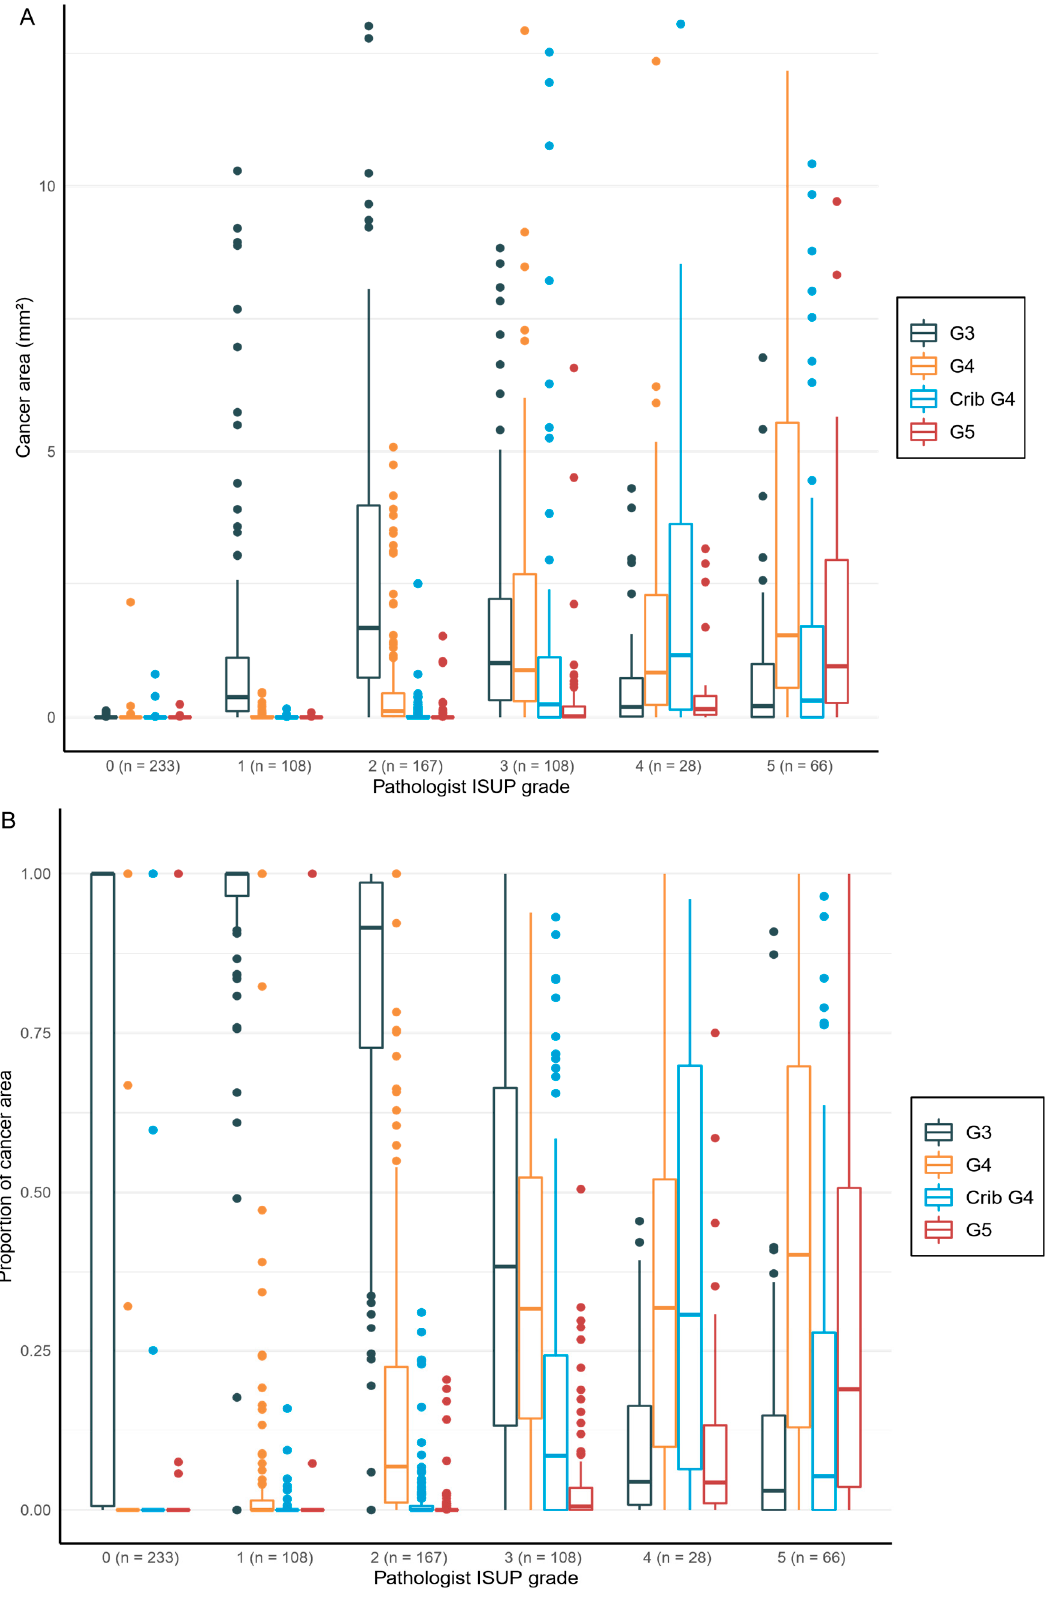
Figure 5. Distribution of the Gleason grade in area ( A ) and percentage of the cancer area ( B ) by AI compared to the grade group by the pathologist. Total n = 710.